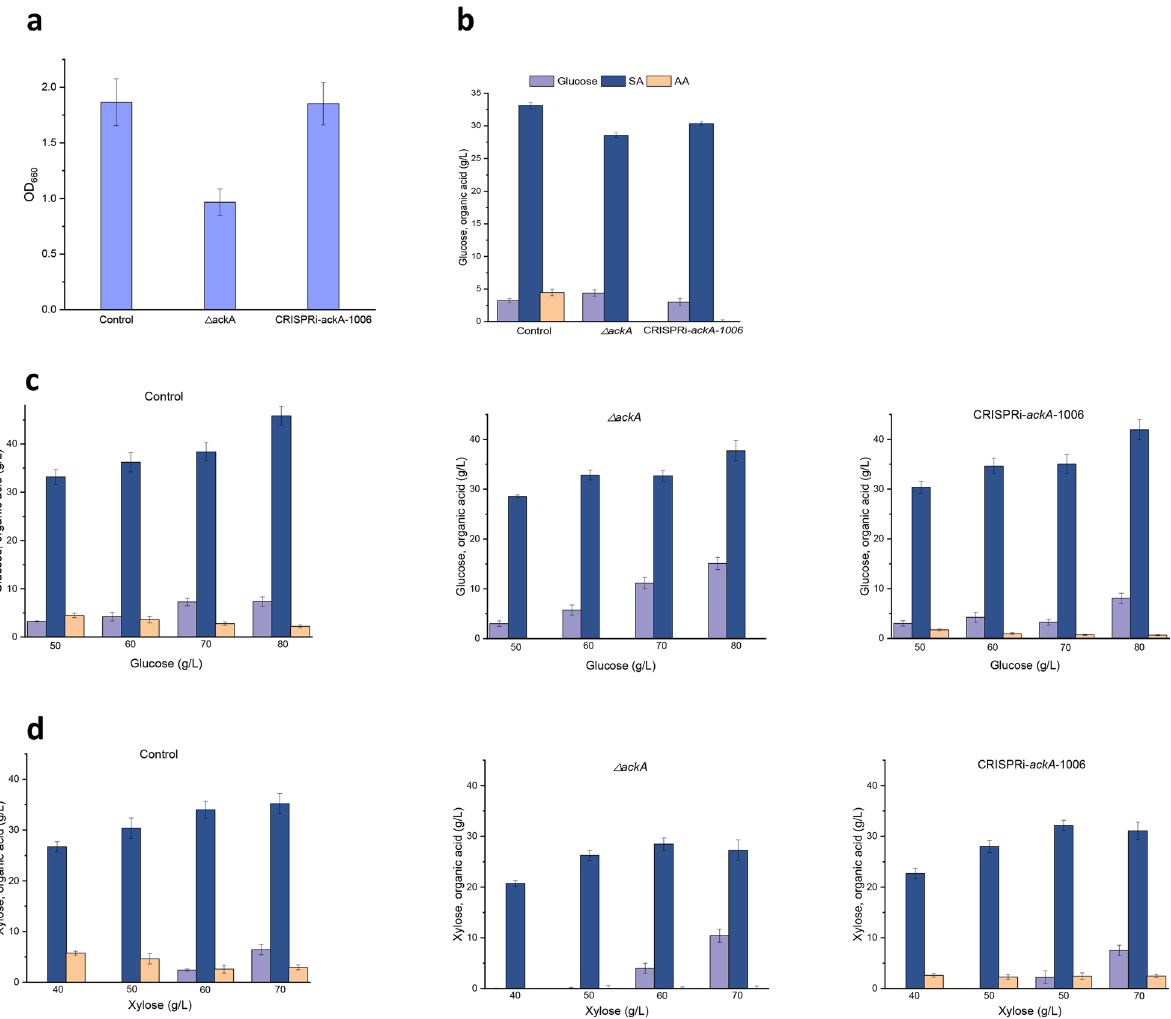
Fig. 4 Effects of CRISPRi suppression of the ackA gene on A. succinogenes strains: cell growth (OD 660 ) ( a ); succinic acid (SA) production; residual glucose concentration; acetic acid (AA) production, ( b ); effect of initial medium glucose concentration on SA production ( c ); effect of initial medium xylose concentration on SA production ( d ). AA production was measured after fermentation for 60 h; purple bar, residual glucose concentration; blue bar, SA concentration; orange bar, AA concentration. Results are the means of at least three independent assays and error bars indicate the standard